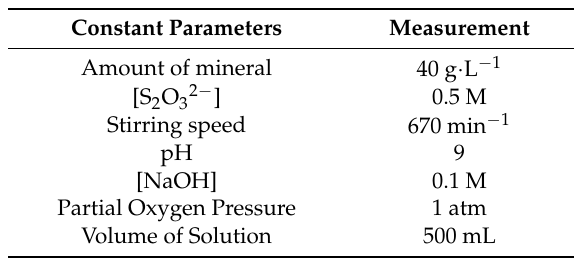
Table 3. Experimental condition constants.